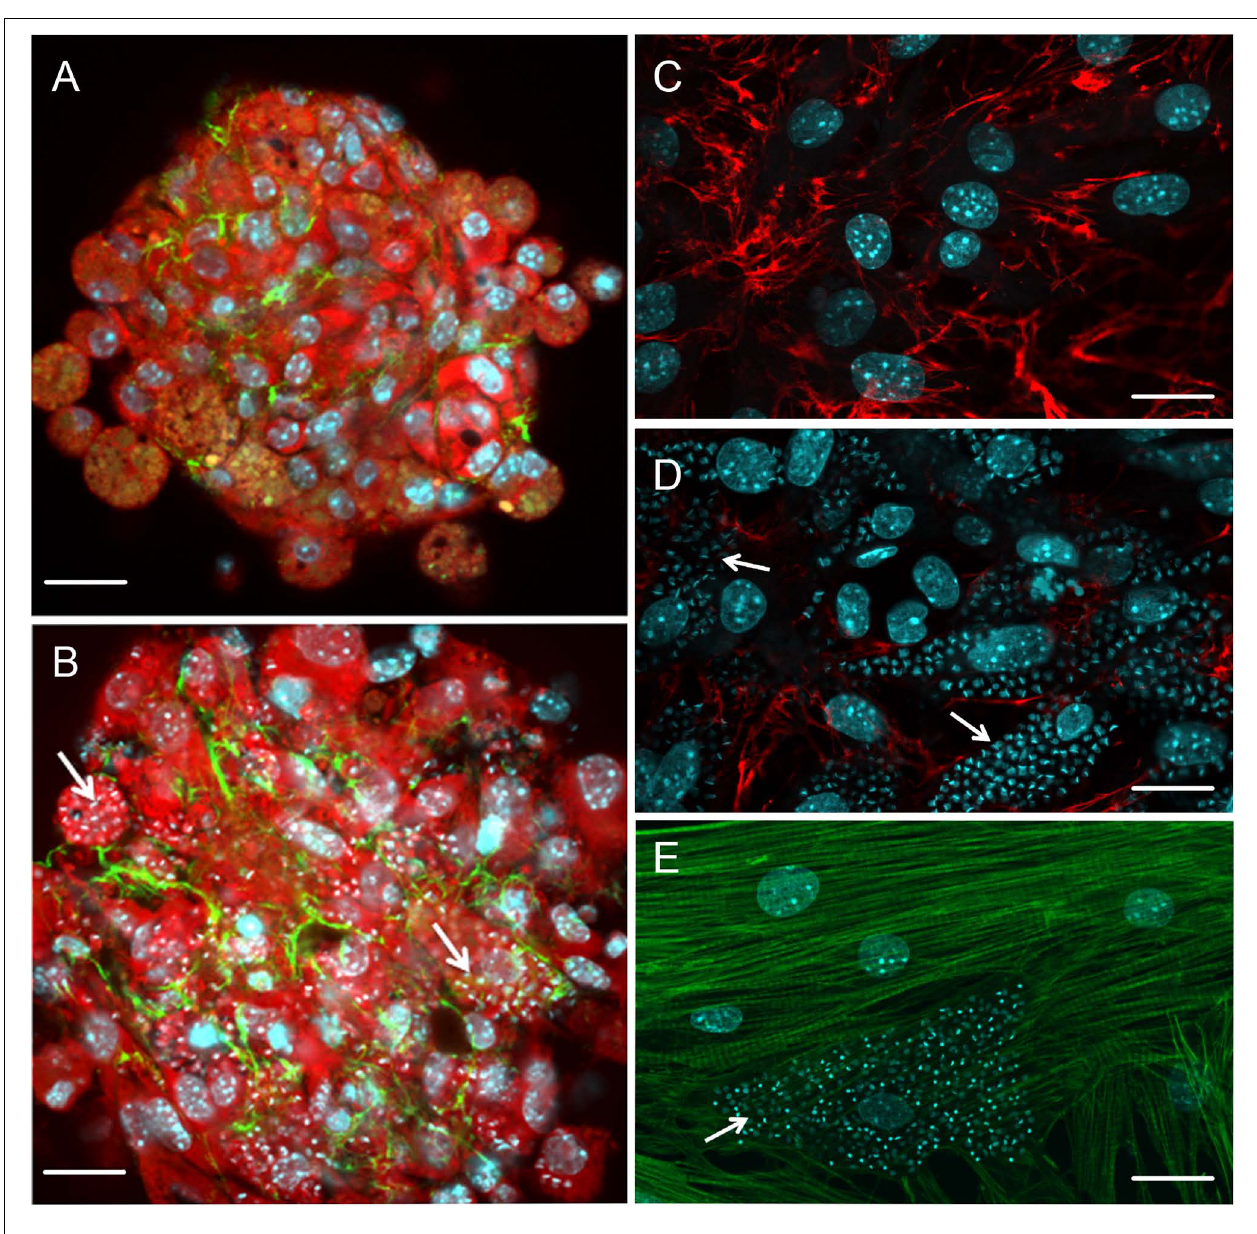
FIGURE 2 | Effect of T. cruzi infection on cardiomyocyte cytoarchitecture and extracellular matrix remodeling (A–E) . T. cruzi -infected cardiomyocyte 3D-culture revealed fibrosis and hypertrophy. Note an increase in spheroid size and the spatial distribution of fibronectin (FN; green) in T. cruzi - infected (B) compared with the uninfected (A) 3D-culture system. However, the FN labeling fainted in highly T. cruzi -infected cells. In contrast, the analysis of FN (red) distribution in cardiomyocyte 2D-culture (C) demonstrates a reduction of this extracellular matrix component in